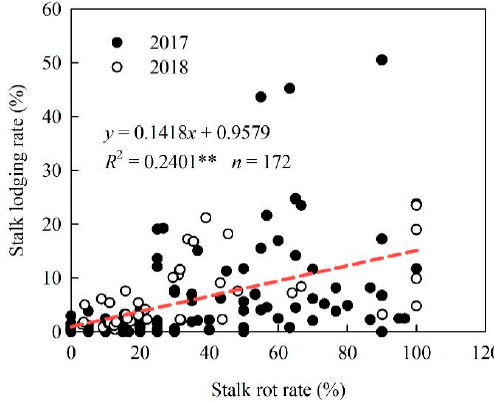
Figure 5. Relation between natural stalk rot and natural stalk lodging of different maize cultivars. ** indicates significance at p < 0.01. The infection index gradually increased with days after PM (Figure 6). The infection index of same treatment was lower in 2017 than that in 2018. The infection index of Dika 517 was lower than that of Zhengdan 958 and Jingnongke 728. Stalk rot also occurred after PM in the treatment that was not inoculated.